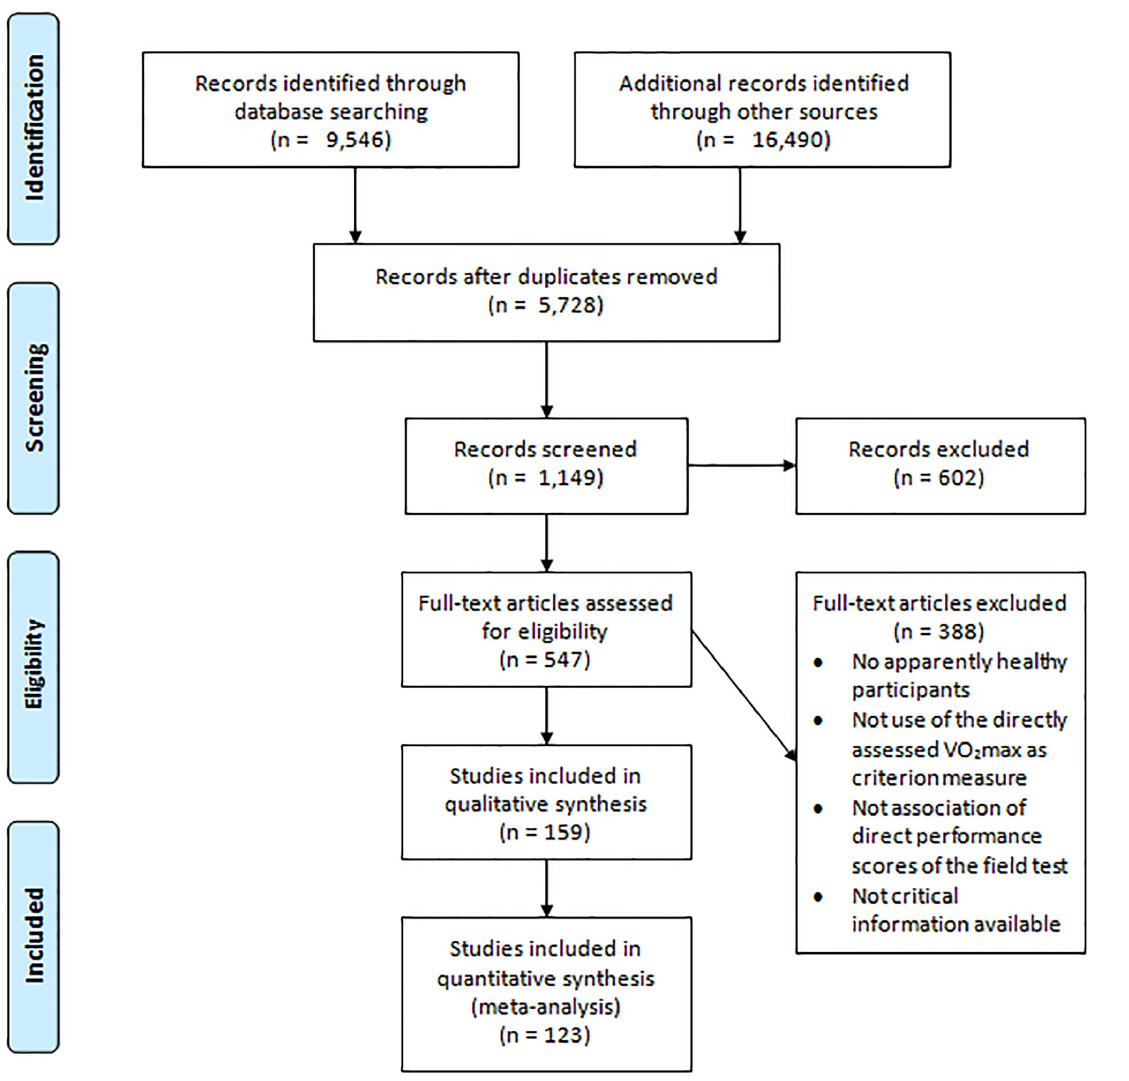
Fig 1. Flow diagram of the study selection